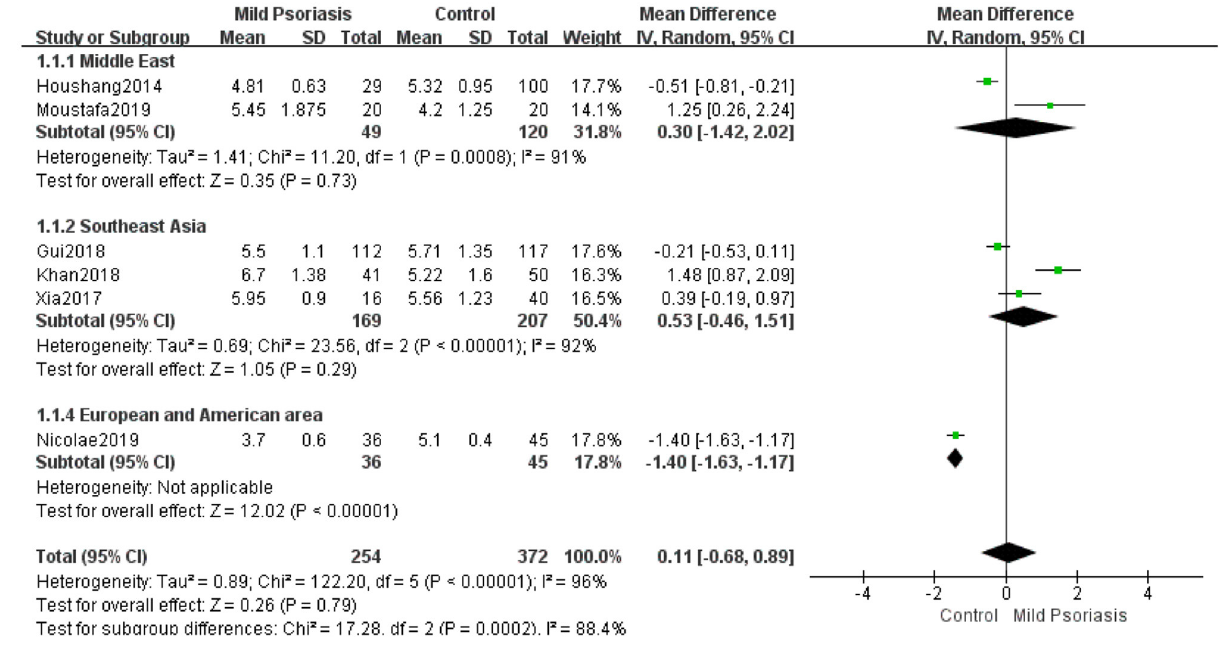
FIGURE 3 | Meta-analysis of the SUA levels of patients with mild psoriasis vs. controls. The MD in SUA levels of patients with mild psoriasis vs. controls. The point estimate (center of each green square) and statistical size (proportional area of the square) are represented. The horizontal lines indicate the 95% confidence intervals. The subtotal and total MD (diamond) were calculated using a random-effects model. MD, mean difference; SUA, serum uric acid.